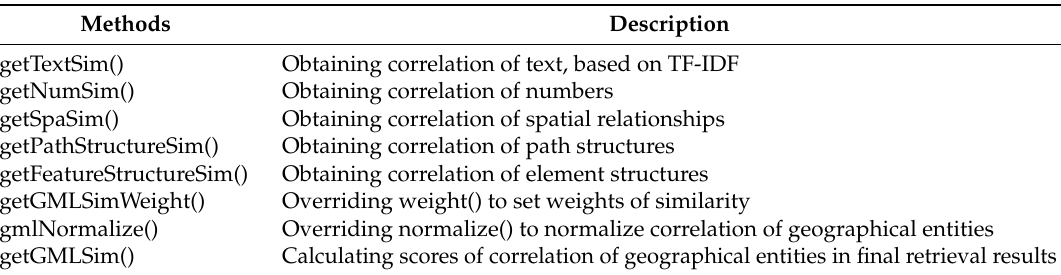
Table 3. Description of the main methods of GMLSimilarity .